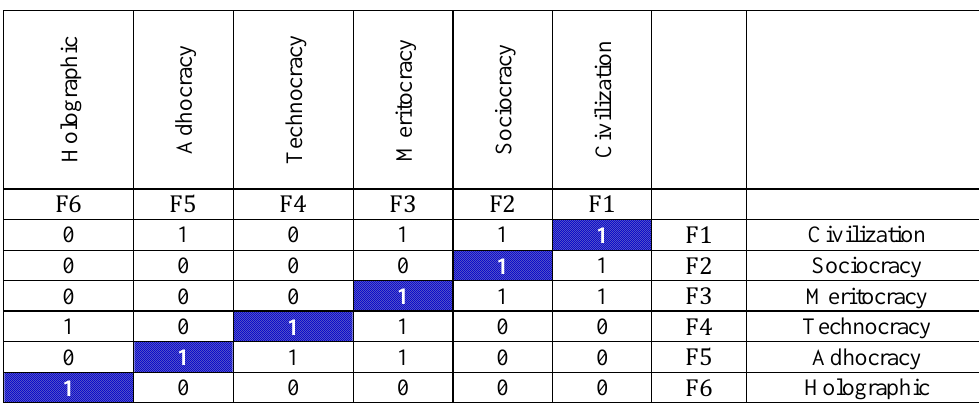
Table 11. Access matrix